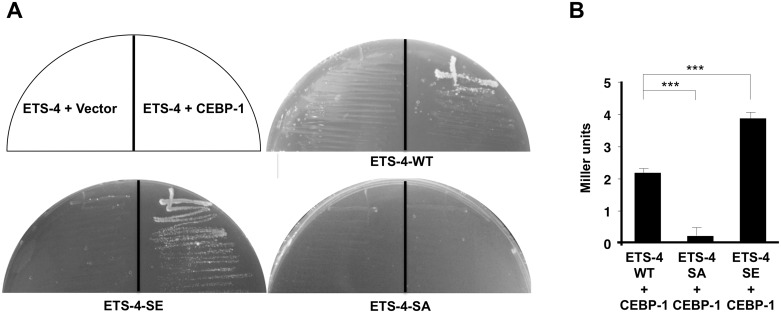
Interaction of ETS-4 with CEBP-1 by yeast two-hybrid assays.(A) The reporter yeast strain L40u was cotransformed with expression vectors encoding LexA DBD-ETS-4, LexA DBD-ETS-4(S73E), LexA DBD-ETS-4(S73A) and GAL4 AD-CEBP-1 as indicated. Yeasts carrying the indicated plasmids were grown on a selective plate lacking histidine and containing 80 mM 5-aminotriazole for 4 days. (B) The reporter yeast strain NMY51 was cotransformed with expression vectors as indicated. Yeasts carrying the indicated plasmids were grown and β-galactosidase activity was determined in cellular extracts as described in Materials and Methods. Backgrounds were determined by cotransforming cells with the control vector pACTII along with the corresponding pBTM116-ETS-4(WT, S73A or S73E,) and the β-galactosidase activities obtained were subtracted from each set of data. Values are given in Miller units. The data are combined from ten independent experiments and quantified by the Welch’s t test. ***P < 0.001. Error bars represent SEM.